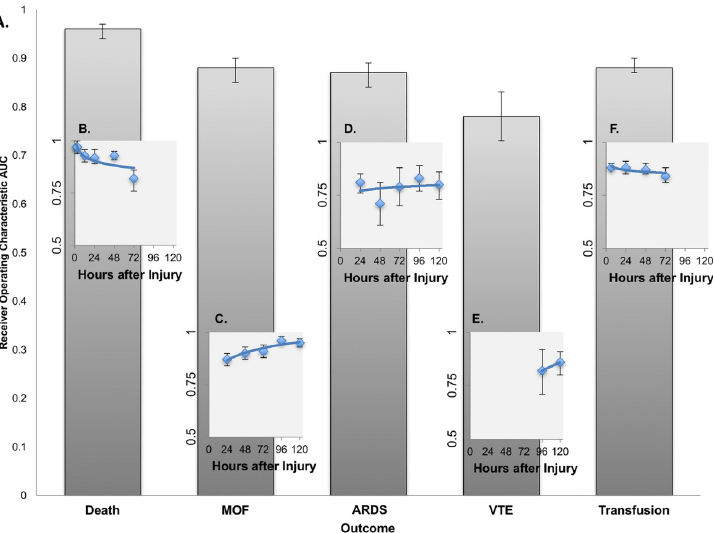
Fig 2. Overall and interval prediction of key outcomes after injury using SuperLearner. A. Overall SuperLearner Prediction of Key Outcomes after Injury using Admission Data B. Interval SuperLearner Prediction of Death after Injury C. Interval SuperLearner Prediction of Multi-Organ Failure by after Injury D. Interval SuperLearner Prediction of Acute Respiratory Distress Syndrome by Interval after Injury E. Interval SuperLearner Prediction of Venous Thromboembolic Events by Interval after Injury F. Interval SuperLearner Prediction of Transfusion Requirement by Interval after Injury. ROC, Receiver Operating Characteristic; AUC, Area Under the Curve; MOF, Multi-Organ Failure; ARDS, Acute Respiratory Distress Syndrome; VTE, Venous Thromboembolic